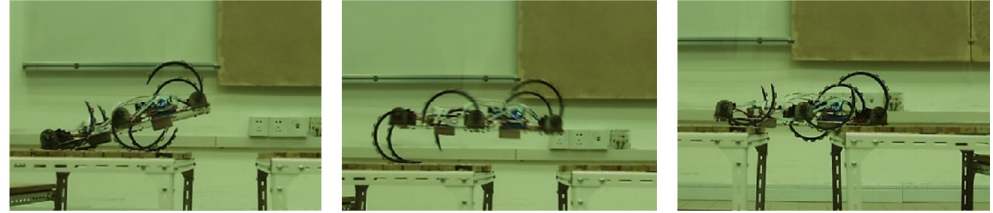
Figure 14. The jumping experiment process of the robot.